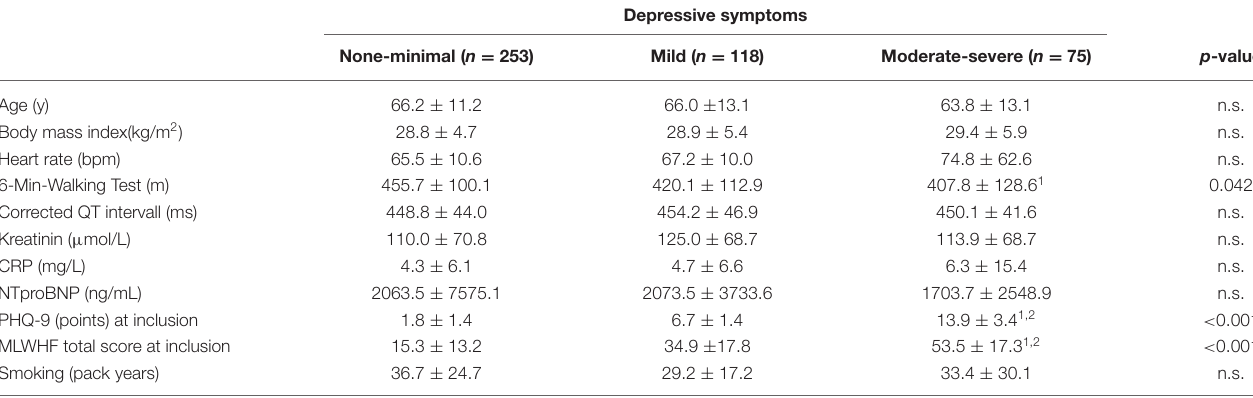
TABLE 3 | Baseline characteristics according to the severity of depressive symptoms.